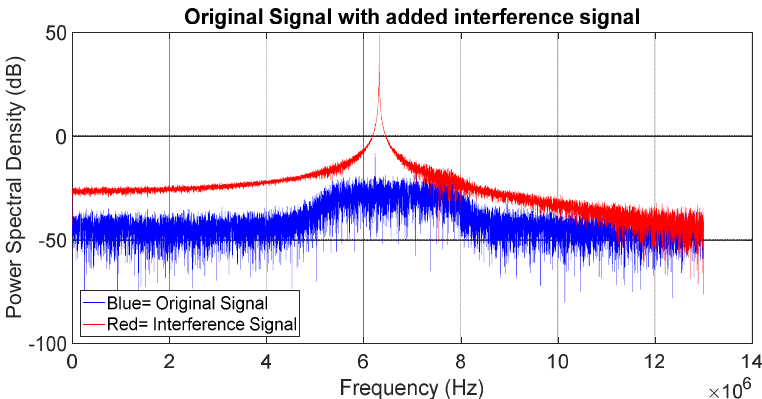
Figure 17. Frequency spectrum of the raw sampled RF front-end data with added sweeping interference at J / No = 80 dB-Hz and freqj = 5.5 to 7.5 MHz .